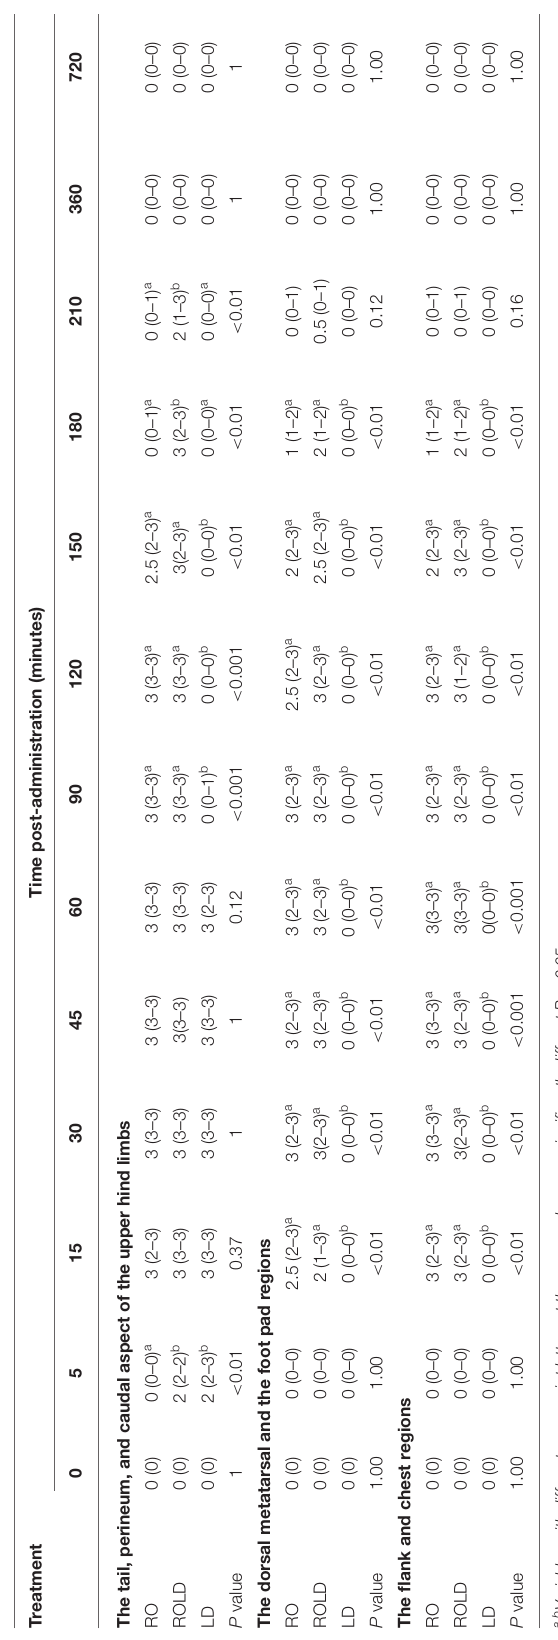
FIGURE 1 | Pinching using artery forceps showing a complete analgesia of the prepuce in male camel post-epidural injection of romifidine (RO) (50 µ g/kg).